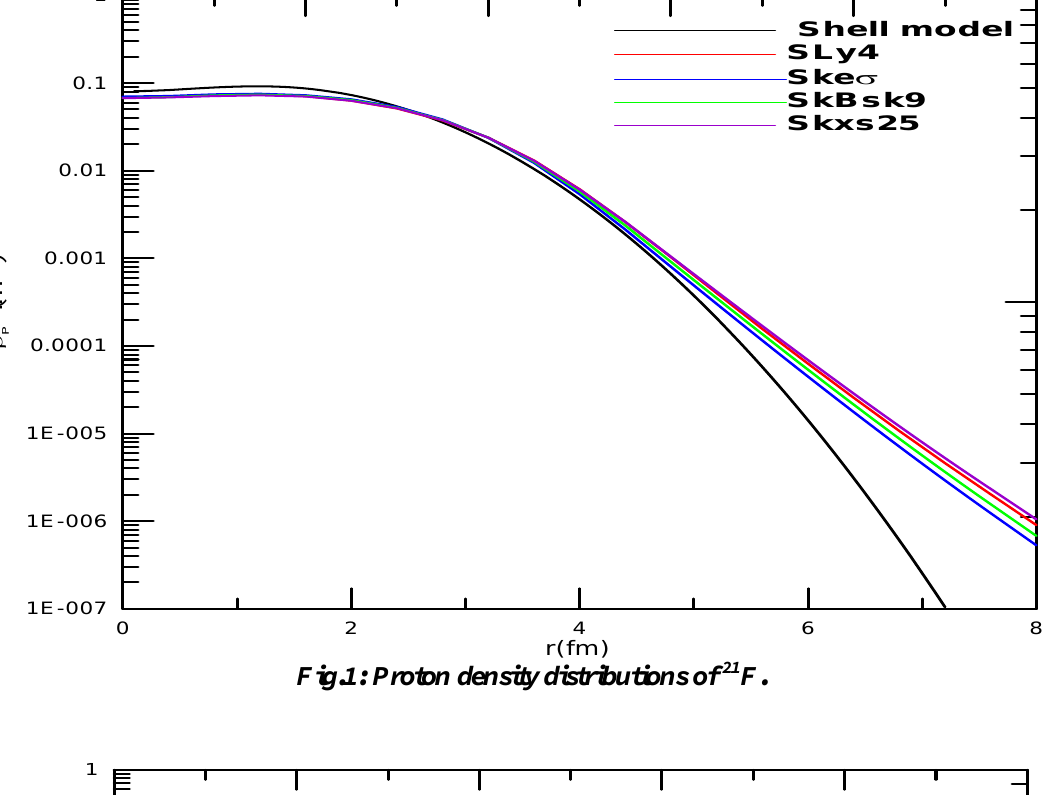
Fig.1: Proton density distributions of 21 F.